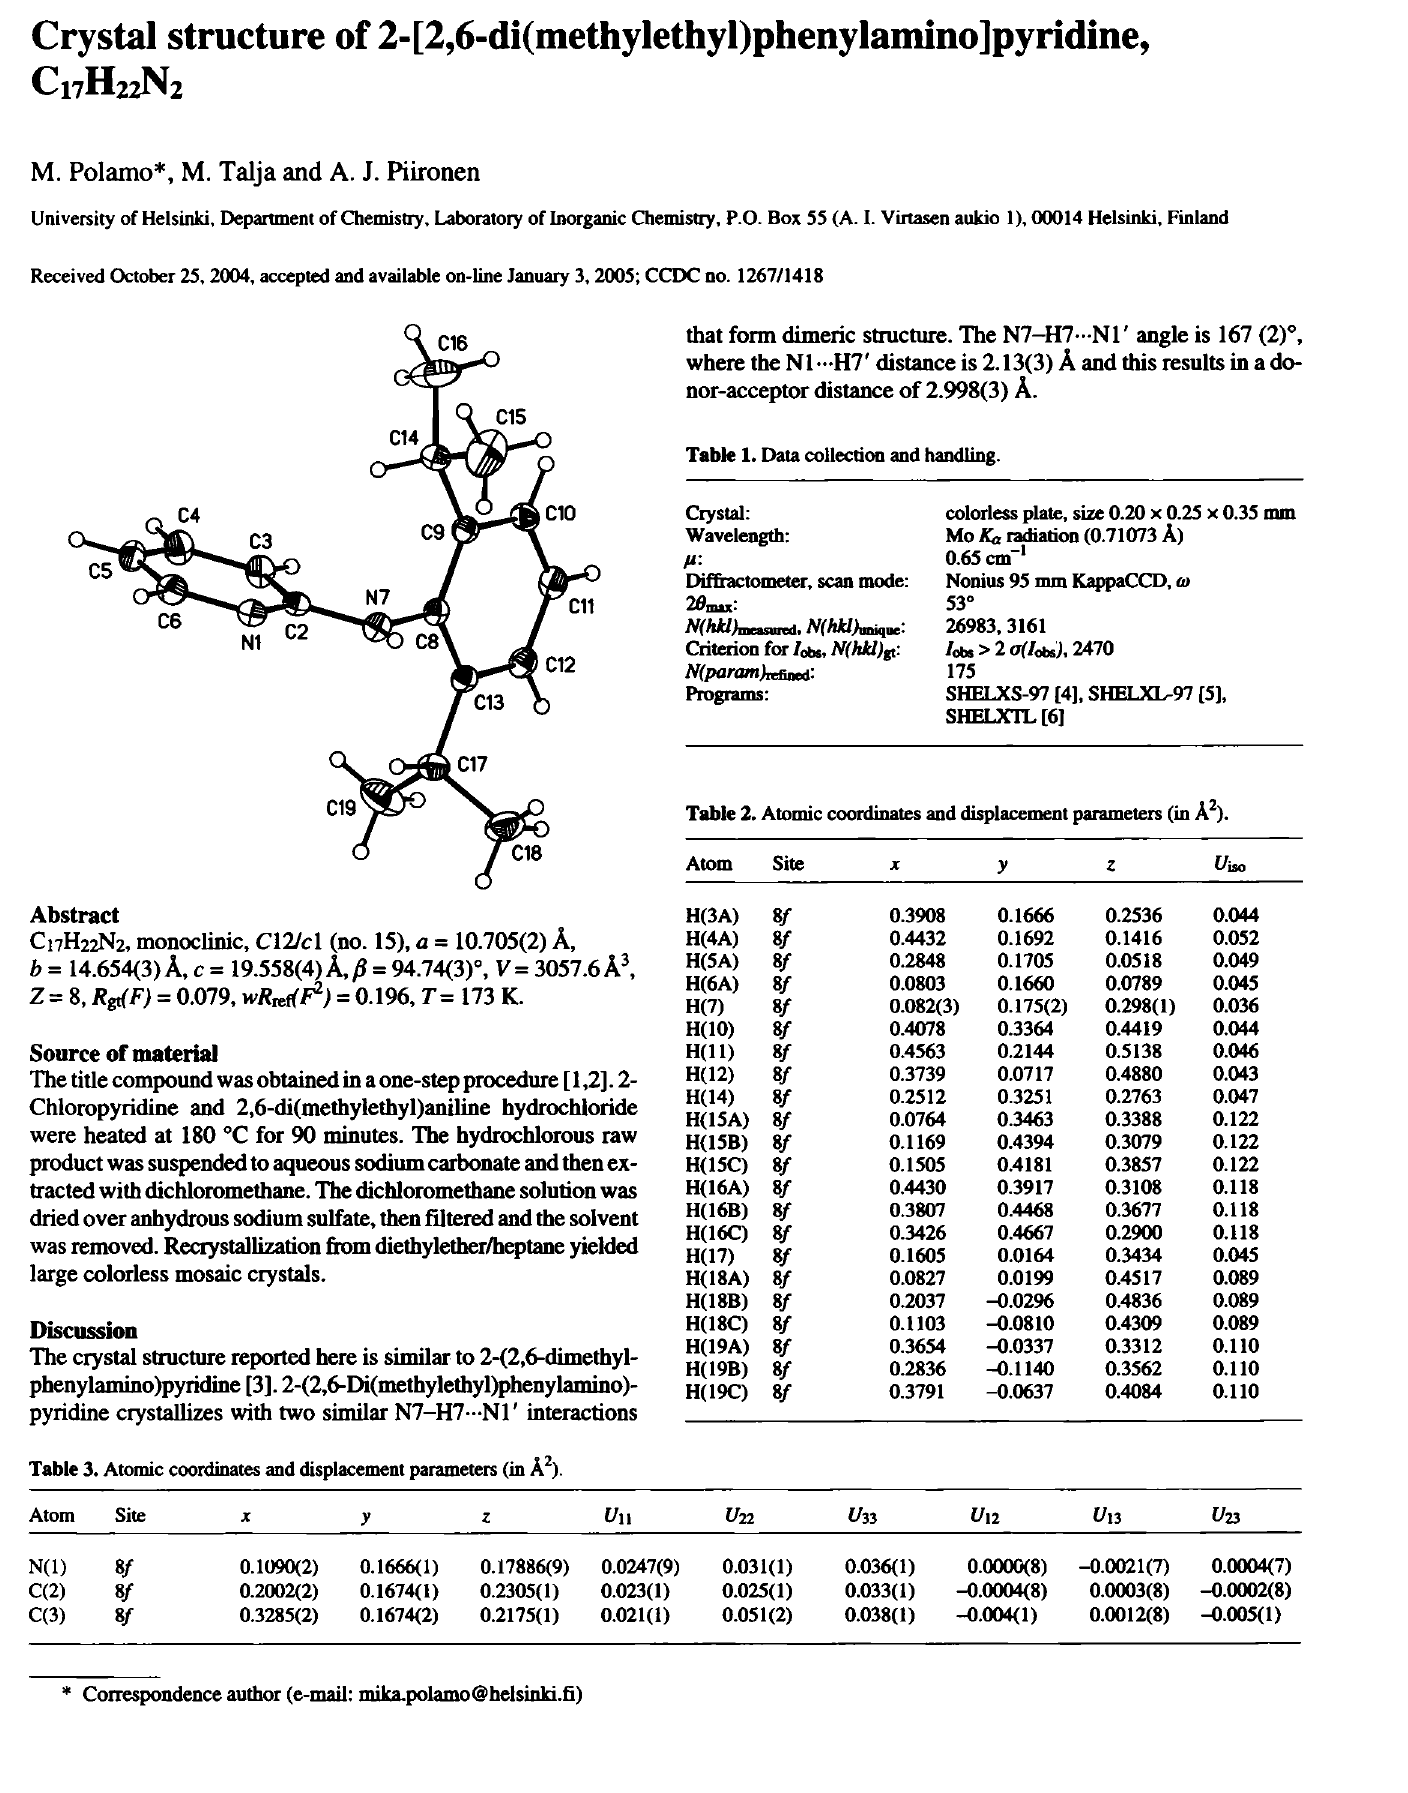
Table 3. Atomic coordinates and displacement parameters (in Ä 2 ).